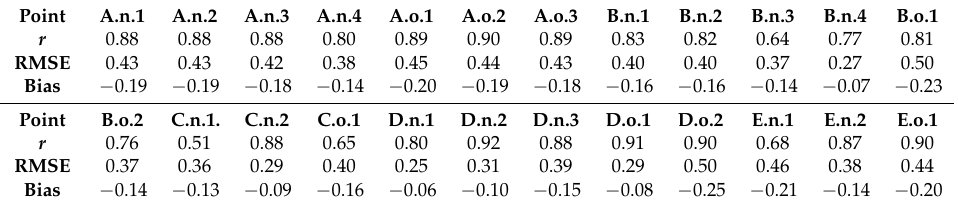
Table 3. Statistical evaluation in terms of the correlation coefficient (r) and RMSE for all 24 points. Point